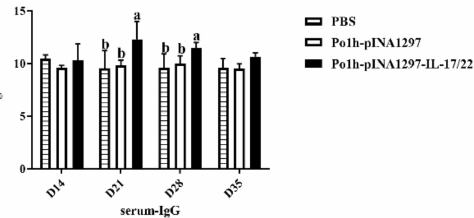
Figure 4. Changes in IgG levels in the serum of the experimental mice. The data with different lowercase letter are significantly different, p < 0.05).